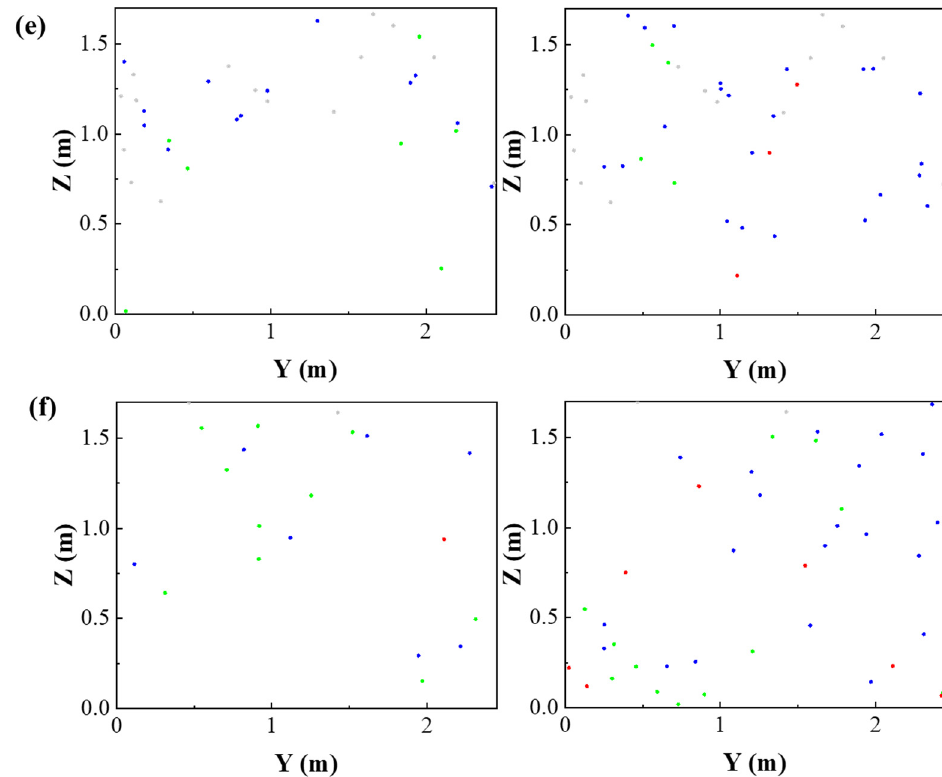
Figure 8. Distribution of BPs deposition locations on typical wall surfaces before and after visitor walking: ( a ) distribution of BPs deposition locations on wall-a; ( b ) distribution of BPs deposition locations on wall-b; ( c ) distribution of BPs deposition locations on wall-c; ( d ) distribution of BPs deposition locations on wall-d; ( e ) distribution of BPs deposition locations on wall-e; ( f ) distribution of BPs deposition locations on wall-f.